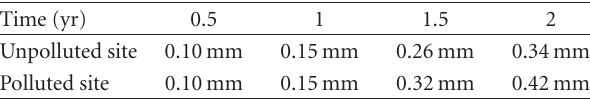
Figure 7: E ff ect of water velocity on corrosion loss [12].